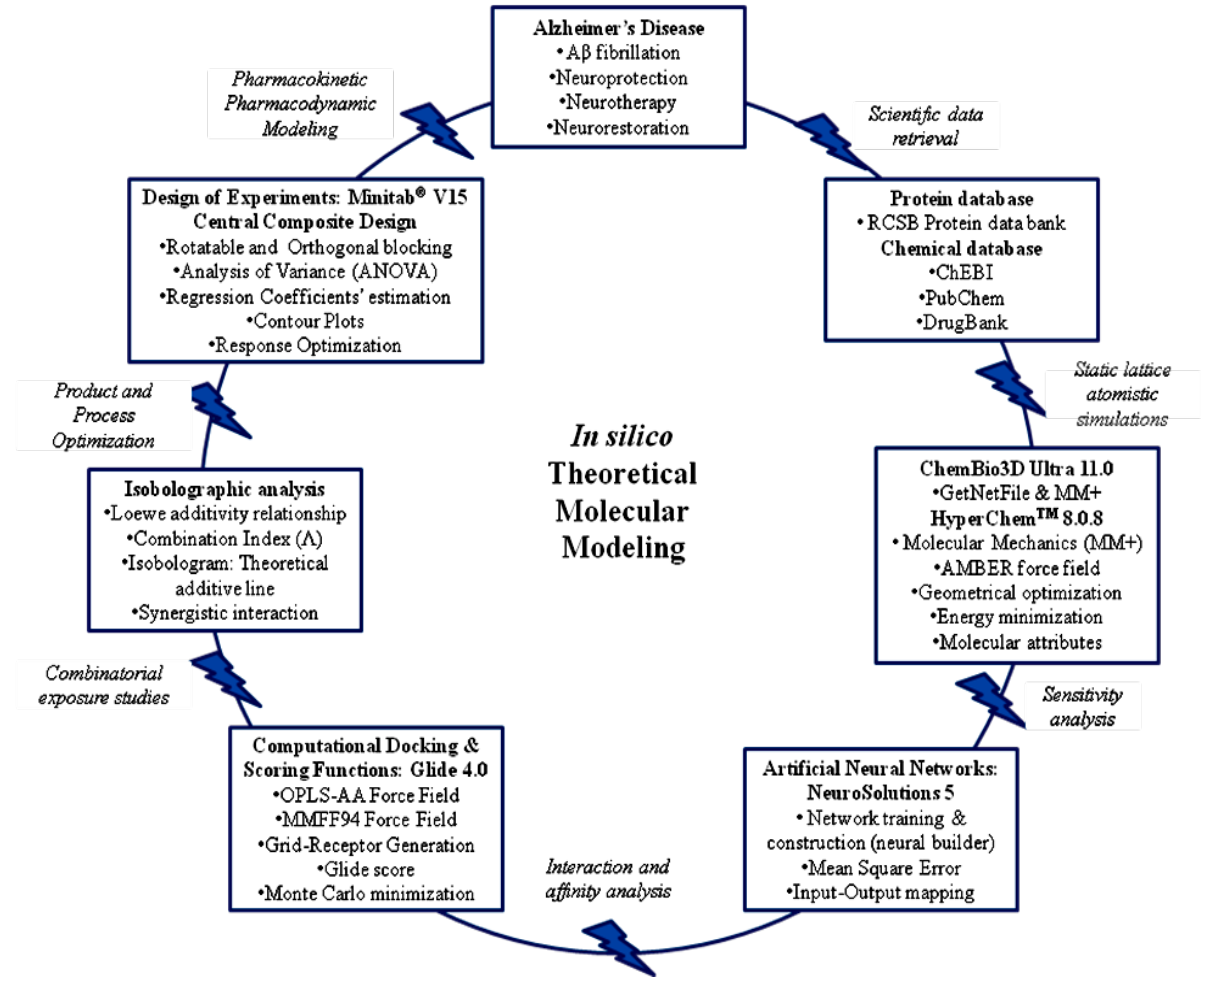
Figure 13. Schematic summarizing the in silico theoretical molecular model developed in this study for the screening of neuroprotective entities for Alzheimer‘s